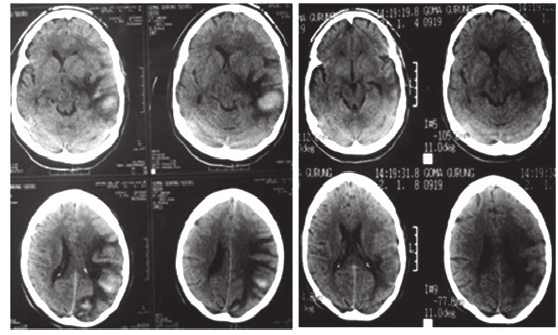
Figure 1: Pre- and post treatment CT